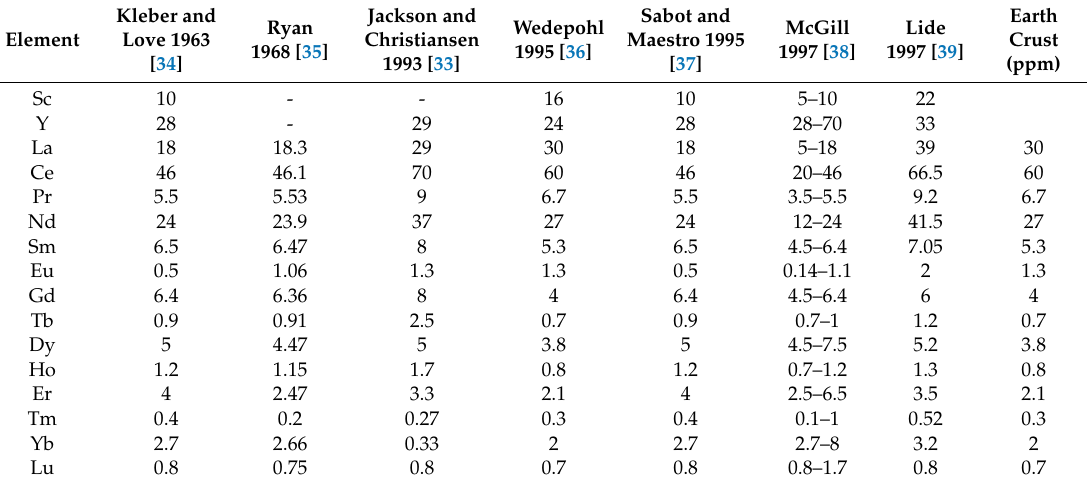
Table 1. Presence of elements in the Earth’s crust in parts per